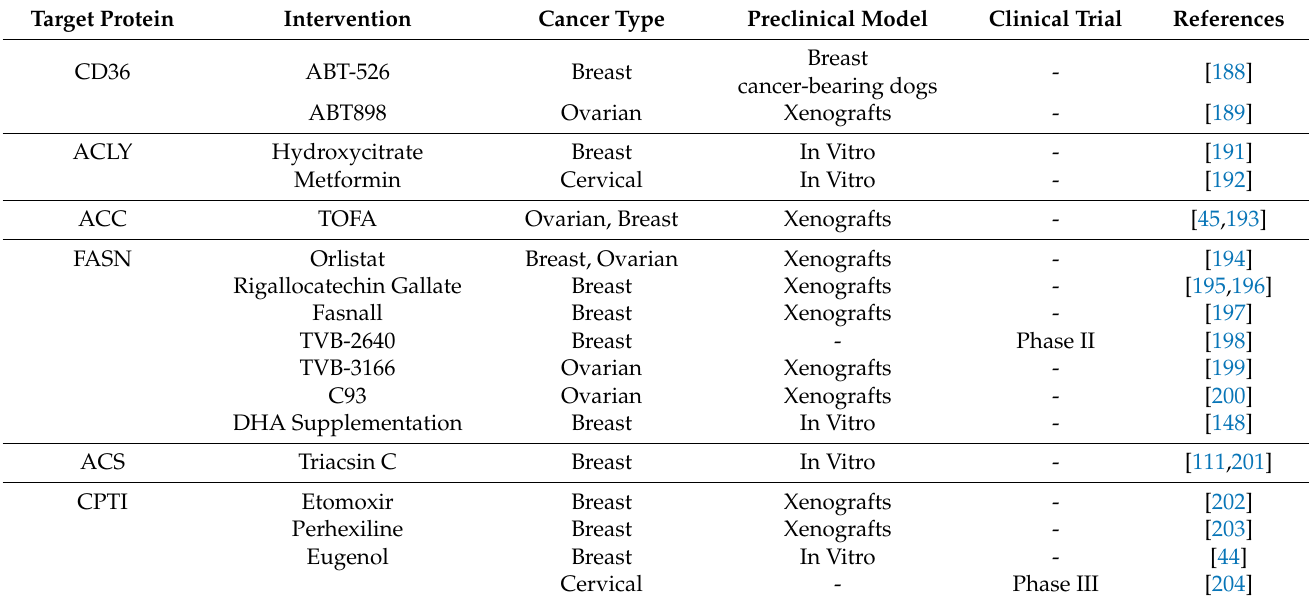
Table 2. A non-exhaustive list of interventions for the main FA metabolism enzymes at various stages of